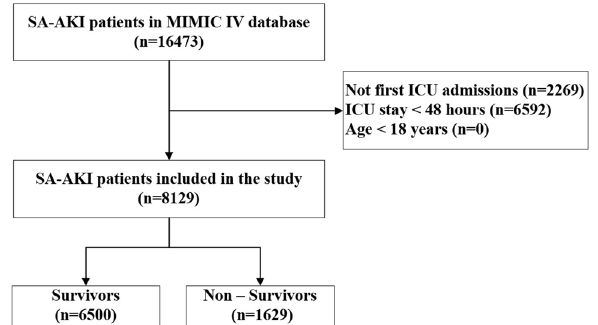
Figure 1. The flowchart of patient selection. MIMIC IV Medical information mort for intensive care IV, ICU Intensive care unit, SA-AKI Sepsis-associated acute kidney